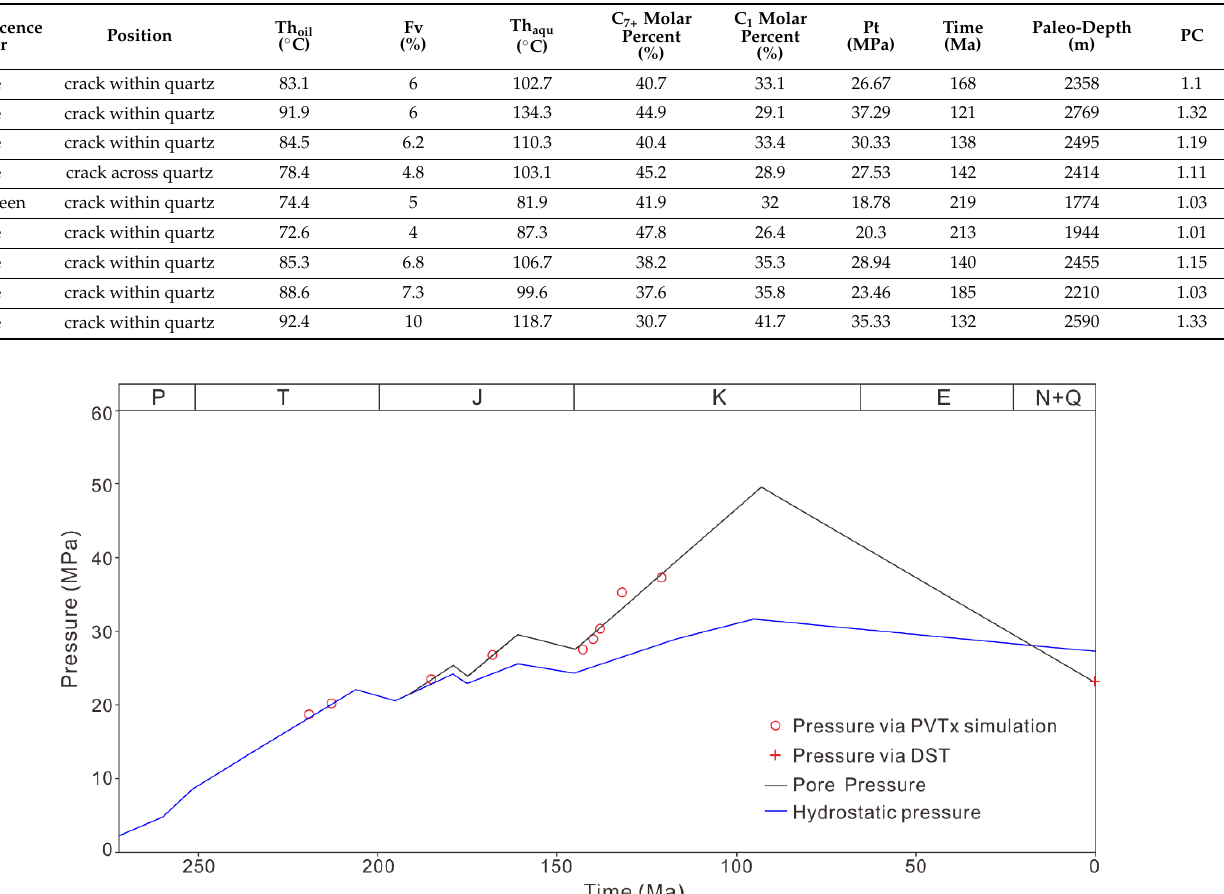
Table 3. Parameters and calculated results of the oil inclusion trapping pressures for the sandstones in the Lower Shihezi Fm. from the well J77 in the Hangjinqi area. Fv: Degree of bubble filling, Pt: Trapping pressure, PC: Pressure coefficient.